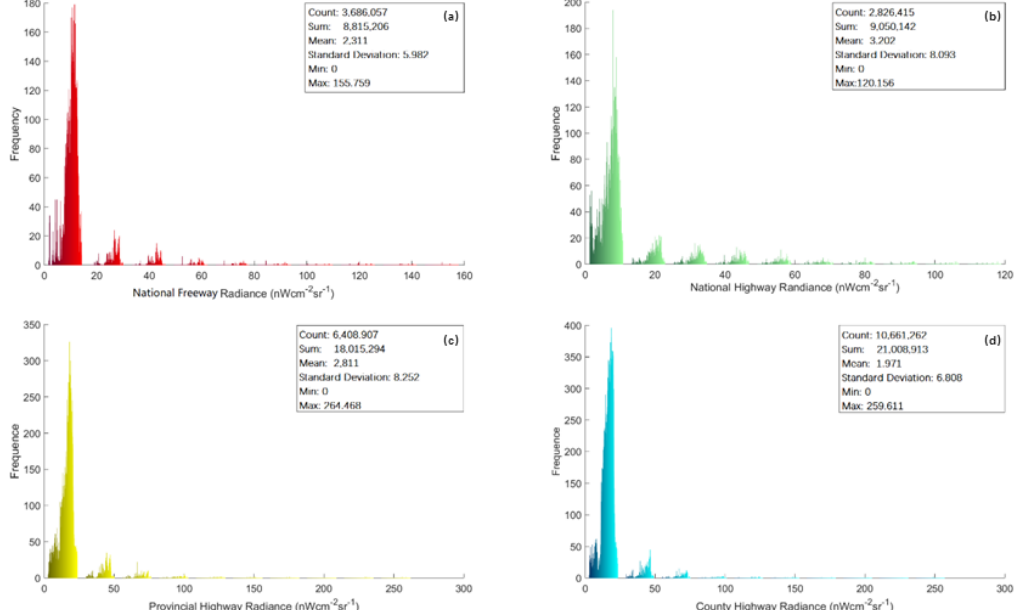
Figure 9. Histogram of the highway nighttime lights: ( a ) National freeway; ( b ) National general highway; ( c ) Provincial highway; ( d ) County highway.